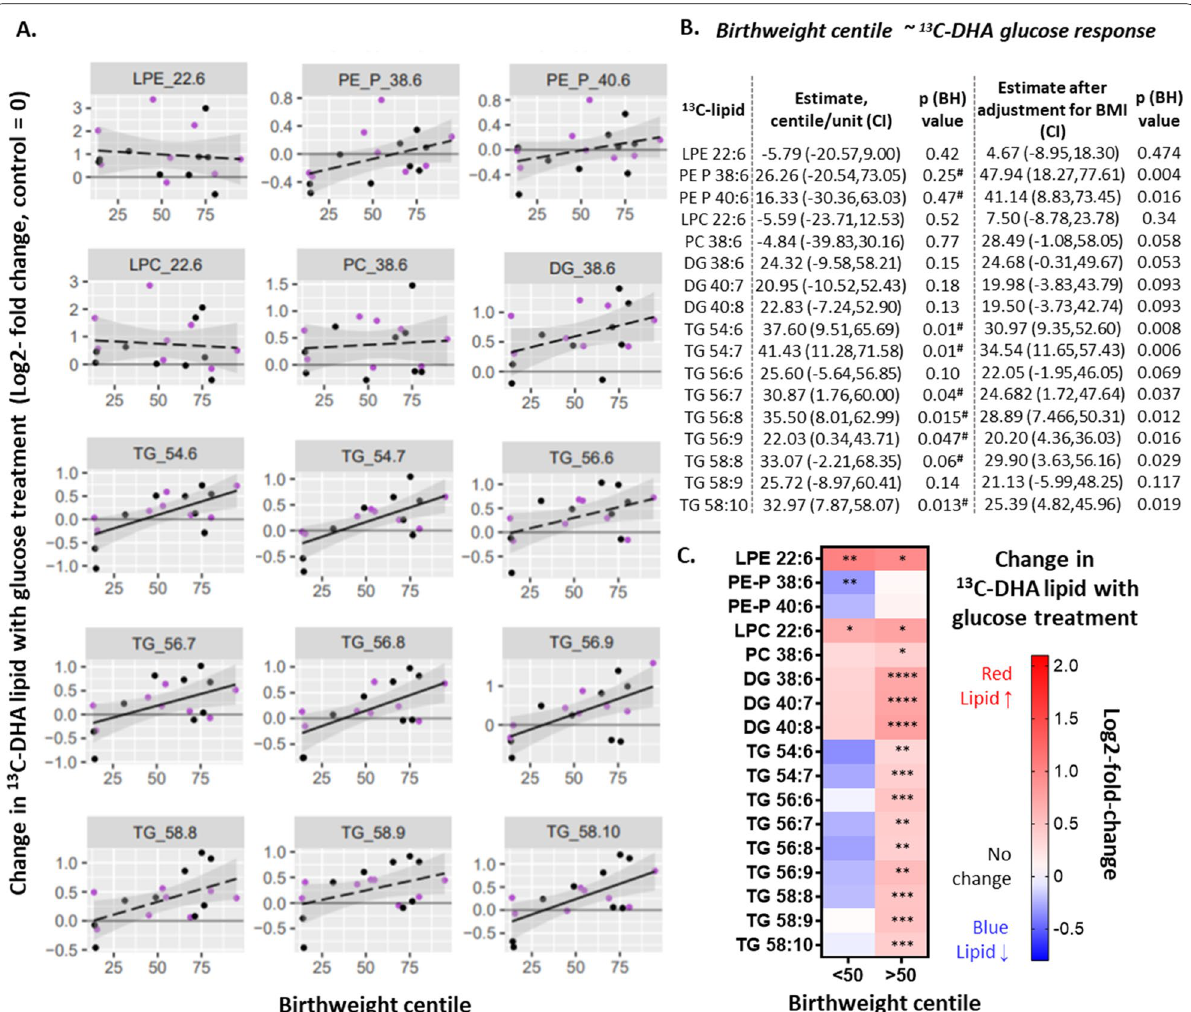
Fig. 6 Associations between glucose‑treatment‑induced changes in 13 C‑DHA lipids (glucose response) and birthweight centile (n 13 C‑DHA lipid with glucose treatment or glucose response (log2‑fold‑change) represents the relative amount of 13 C‑DHA lipid in placental explants treated with glucose (10 mmol/L) compared to control explants from the same placenta. Positive values indicate an increase in 13 C‑DHA lipids compared to the control, whilst negative values indicate a decrease. Linear regression was run with birthweight centile as the outcome and glucose response as the exposure variable, with or without adjusting for (Z‑score, log‑2) BMI. Solid lines show significant associations while dashed lines show non‑significant associations. Shaded areas show 95% confidence intervals. Key—Purple: non GDM, Black: GDM. Significance retained after adjusting for (Z‑score, log‑2) BMI (#). The Benjamini–Hochberg method was used to correct for multiple testing. C Heat map illustrating glucose response in placental explants from births with birthweight centile < 50 and from births with birthweight centile > 50. Positive values (red) indicate an increase in 13 C‑DHA lipids compared to the control, while negative values (blue) indicate a decrease. Asterisks indicate significant differences between 10 mmol/L glucose treatment and the control (5 mmol/L) *p < 0.05, **p < 0.01, ***p < 0.001, ****p < 0.0001. Comparisons were made for each lipid by repeated measures analysis of variance followed by the Benjamini–Hochberg correction for multiple comparisons. BH Benjamini– Hochberg, CI confidence interval, DG diacylglycerol, DHA docosahexaenoic acid, GDM gestational diabetes, LPC lyso‑phosphatidylcholine, LPE lyso‑phosphatidylethanolamine, PC phosphatidylcholine, PE-P phosphatidylethanolamine‑plasmalogen, TG